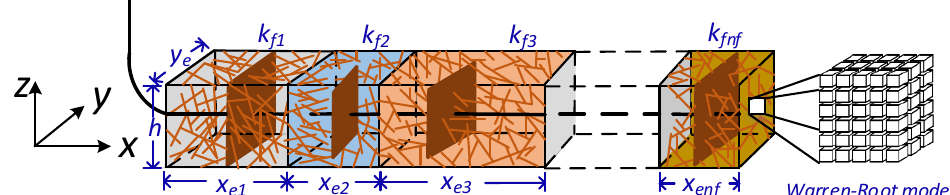
Figure 1. Multiple fractured horizontal wells (MFHWs) through a compartmentalized heterogeneous reservoir.